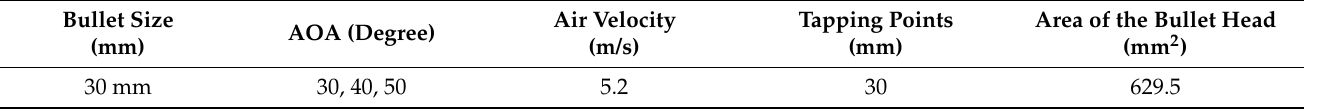
Table 2. Conditions of bullet head in design II. Figure 2. Dimensions ( a ) and geometry ( b ) of the bullet head in design II.